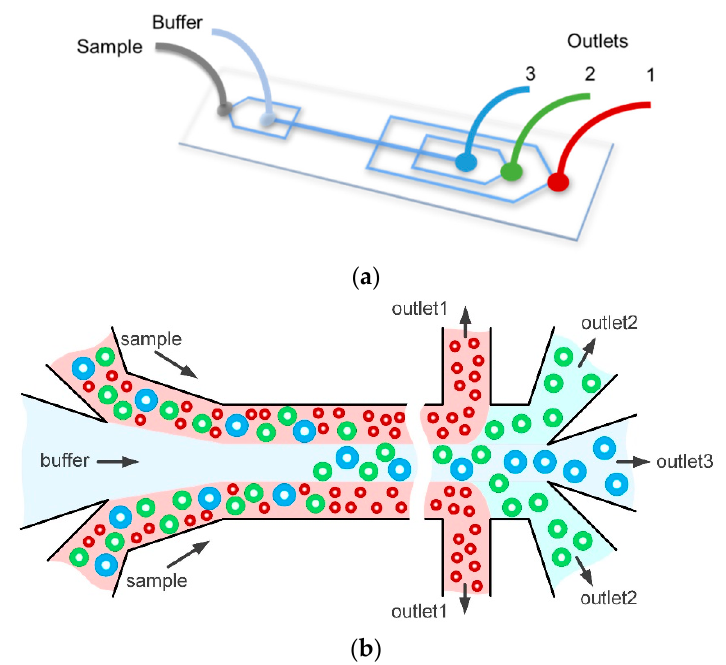
Figure 1. Illustrations of device setup and particle behaviors in device. ( a ) Schematic of device. The buffer enters in the first inlet and the sample behind, resulting in the sample nearest the walls and the buffer in the center. ( b ) Schematic of particle migration in an ideal situation with the smallest particles exiting in outlet 1, the largest in outlet 3 and those in between in outlet 2.